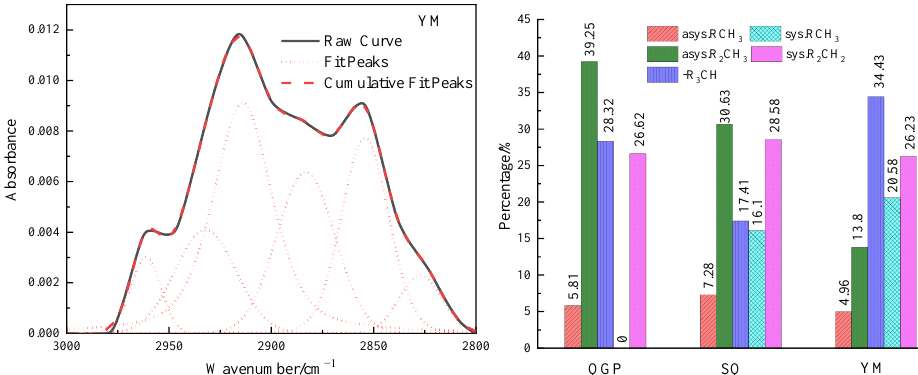
Figure 4. Fitting results and occurrence content of aliphatic hydrocarbons in coal